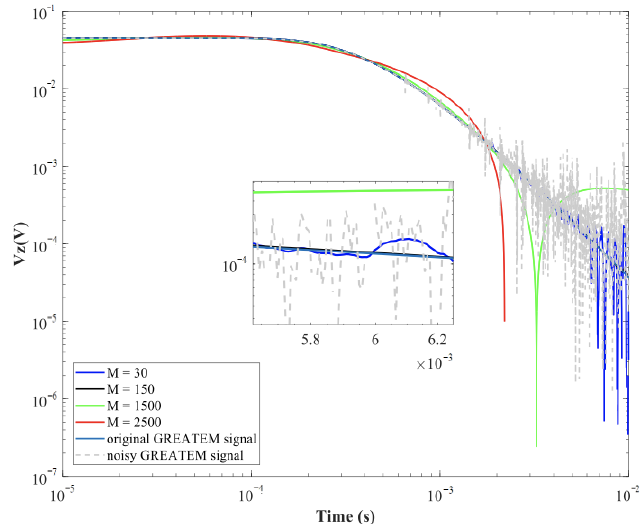
Figure 2. Comparison of signals after de-noising with different window lengths in the SSA.